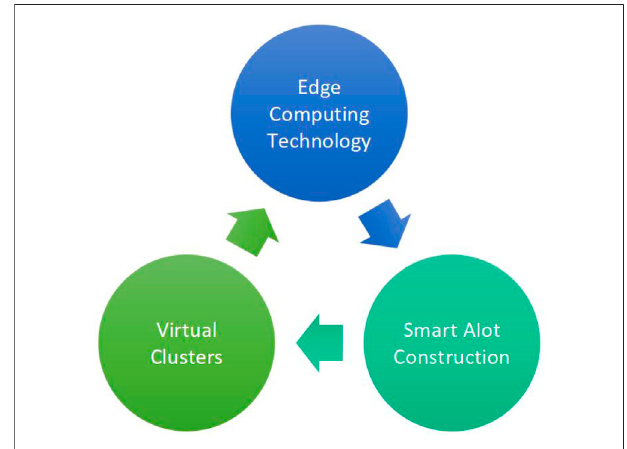
FIGURE 1 | Reliable edge-computing technology and smart AIoT